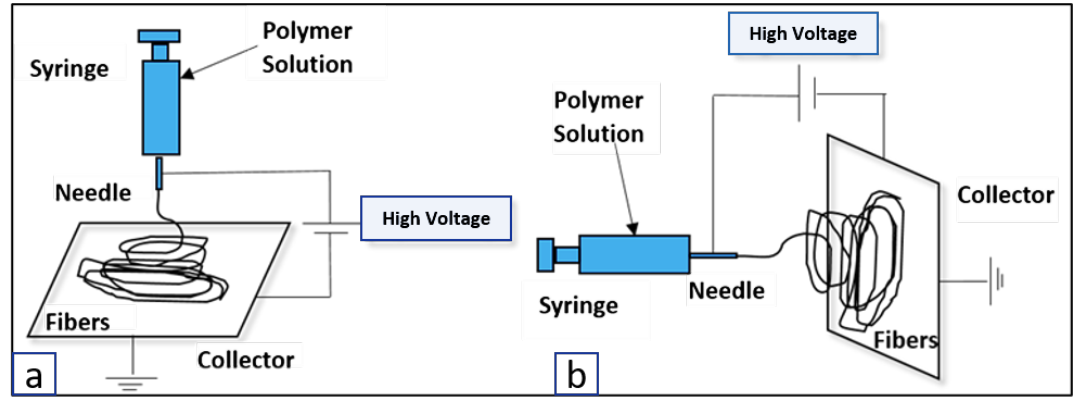
Figure 1. ( a ) Schematics of electrospinning apparatus of vertical setup and ( b ) horizontal setup.